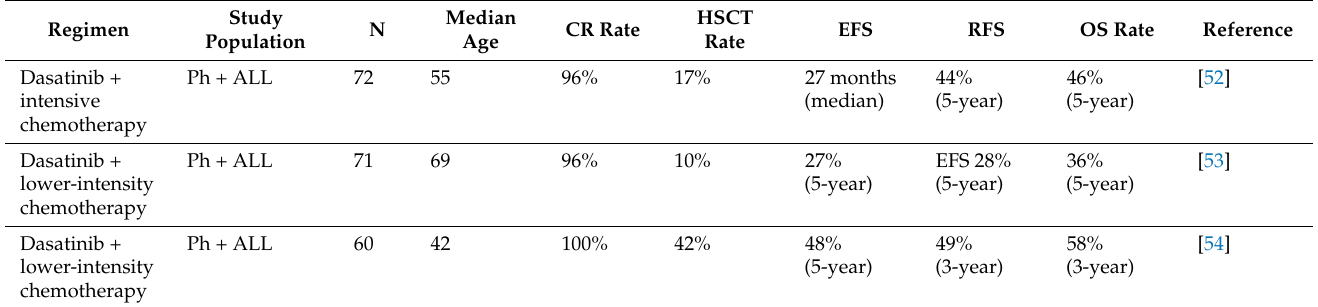
Table 6. Dasatinib/chemotherapy combination